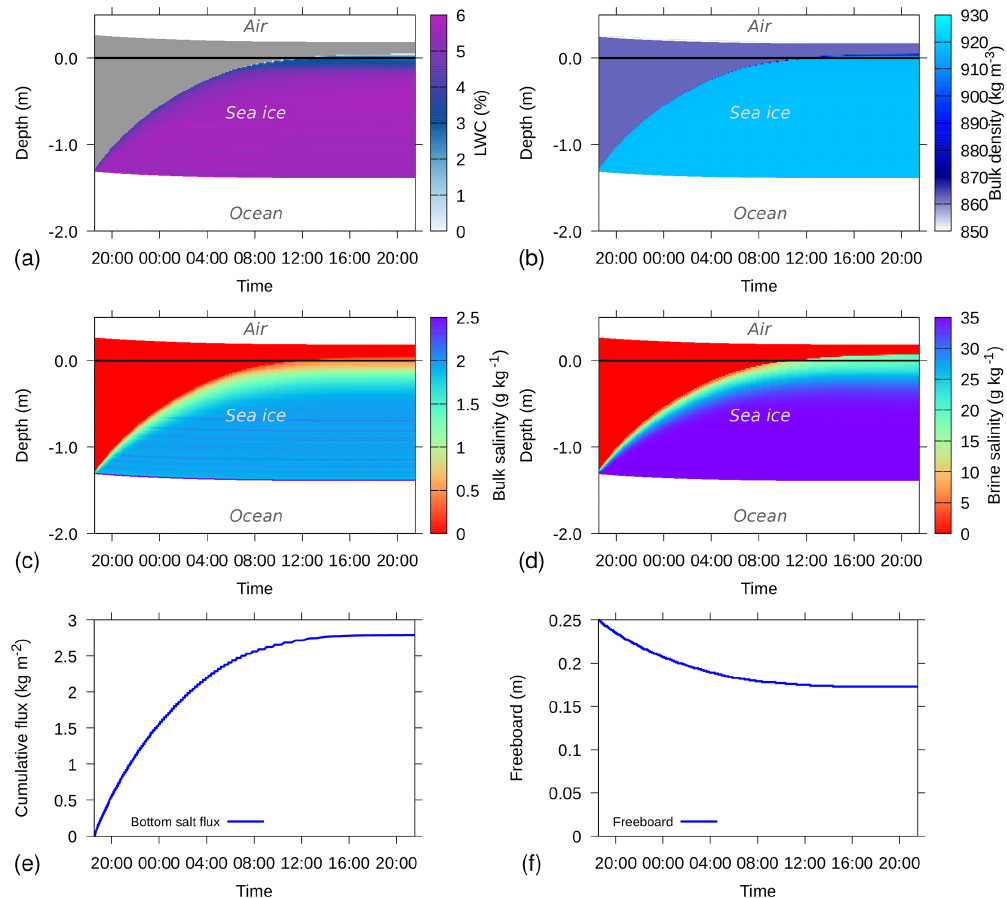
Figure 4. Example simulation where initially dry, porous freshwater ice with 94% volumetric ice content is placed into ocean water with a salinity of 35gkg − 1 . Shown are (a) liquid water content (LWC), (b) bulk density, (c) bulk salinity, (d) brine salinity, (e) cumulative salt flux at the bottom of the sea ice, and (f) freeboard. In (a) , dry parts of the ice are colored grey. In (a–d) , the depth on the y axis is relative to sea level, i.e., sea level is 0 and indicated by the solid black